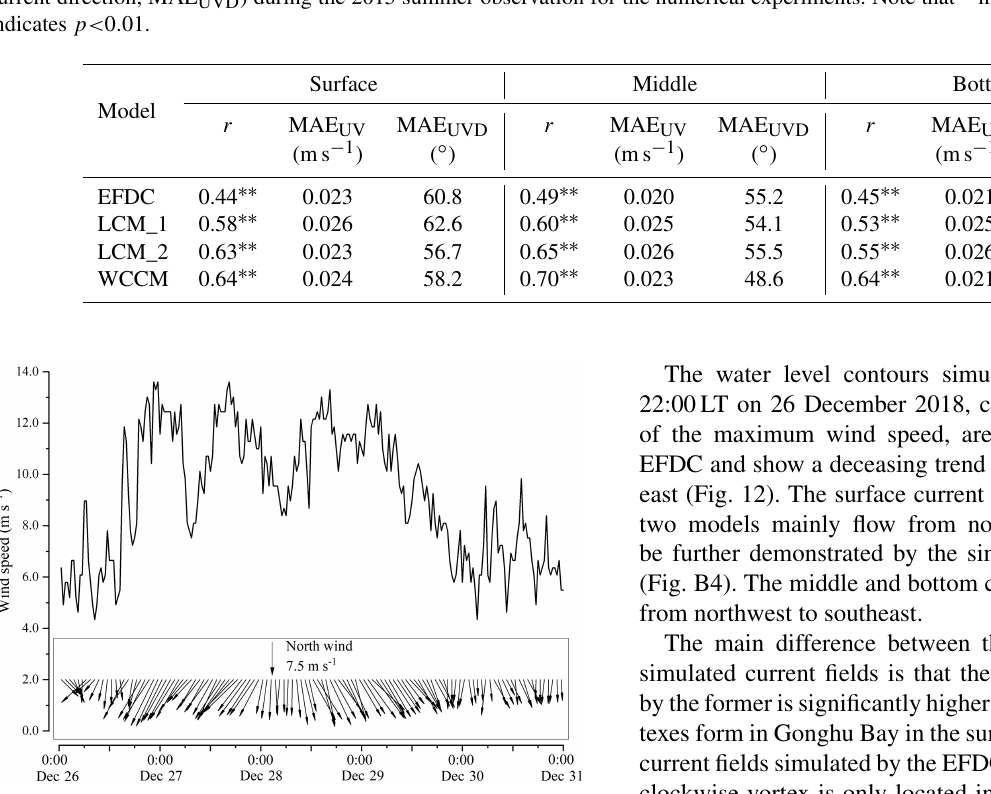
Figure 9. Variation of wind speed and direction at 10m above the water surface at the LHWS during the 2018 winter